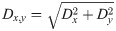
Three-dimensional reflectance traction microscopy applied to a mechanically deformed collagen matrix.(A) Schematic illustration of the experimental setup with side view (i) and top view (ii). A polydimethylsiloxane (PDMS) channel (20 mm × 3 mm) is in contact with collagen gel and is inflated with air. When air is released, the squeezed collagen gel relaxes to a stress-free state, resulting in a deformation field which is expected to follow the arrows in (i) and (ii). The red rectangle encloses the volume of the confocal imaging field of view. (B) The 3D deformation field calculated with PVC algorithm. Deformation along z-axis (Dz) of three selected cross-sections (corresponding to the green lines in A(ii)) are shown as color maps. The lateral deformation field (Dx and Dy) of a selected horizontal cross-section is shown as arrows. The arrows are color coded by the magnitude of the lateral deformation field Dx,y=Dx2+Dy2.